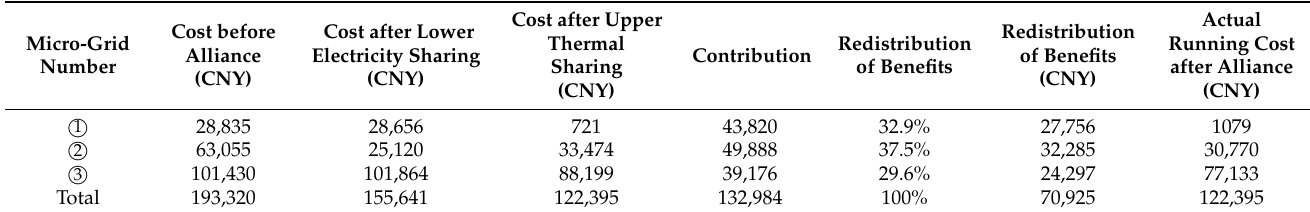
Table A3. Reasonable redistribution results of multi-micro-grid alliance income.